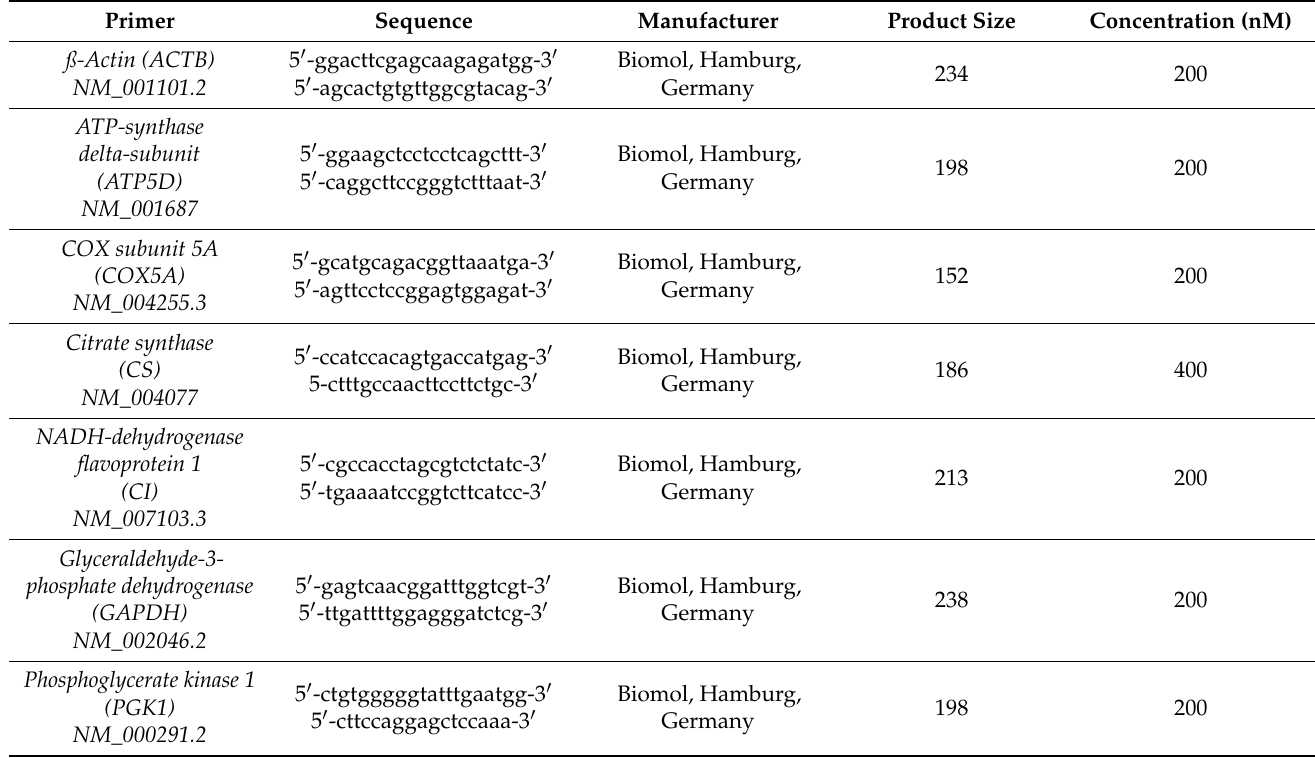
Table 1. Oligonucleotide primer sequences, product sizes, and primer concentrations for quantitative real-time PCR.